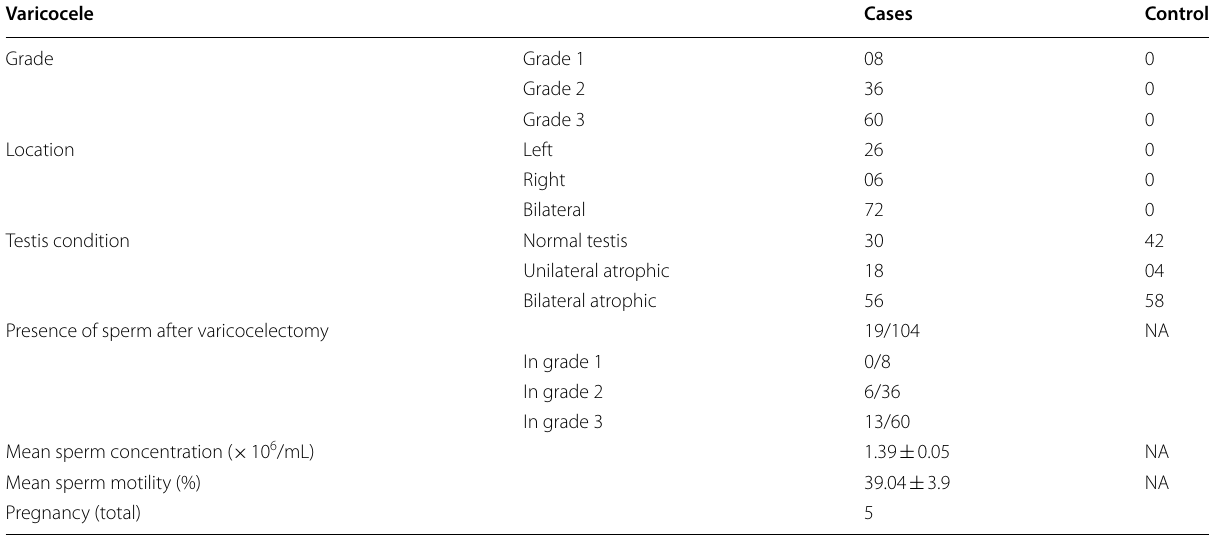
Table 1 Preoperative characteristics and post-operative outcome of varicocele patients Varicocele